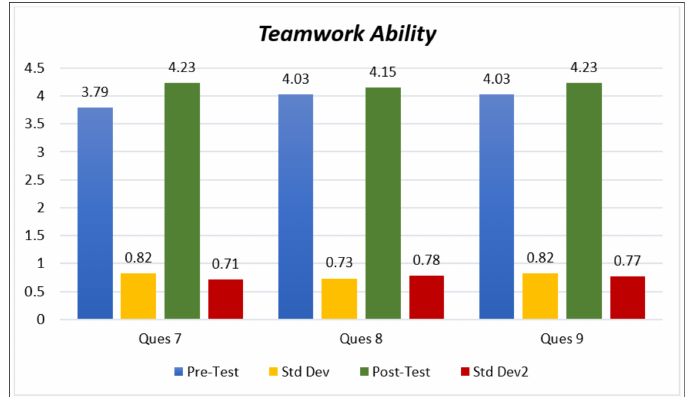
Figure 12. Students’ teamwork ability in the previous test and the